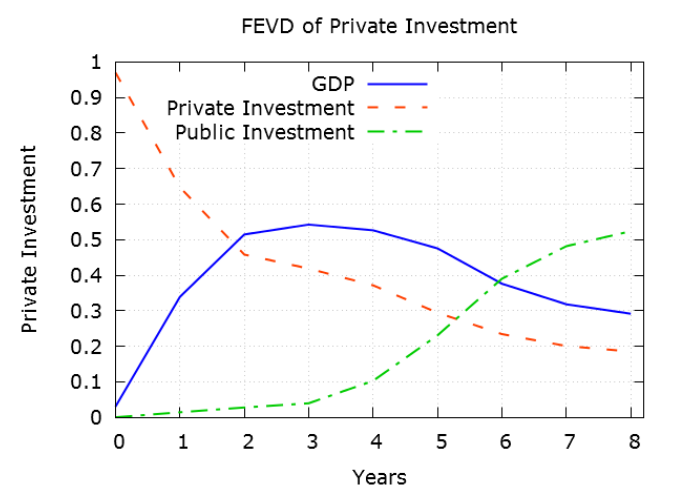
Figure 4 : Variance decomposition of private investment, total public investment